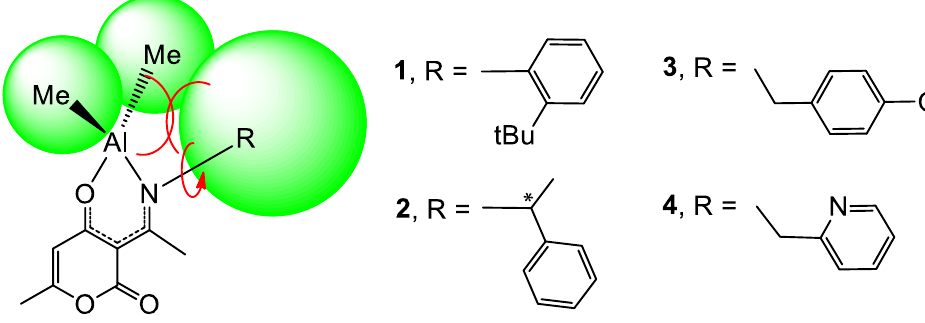
Figure 1. A schematic drawing of the aluminum compounds 1–4 showing the steric hindrance of the Al-Me groups with the imine substituents, * denoted chiral